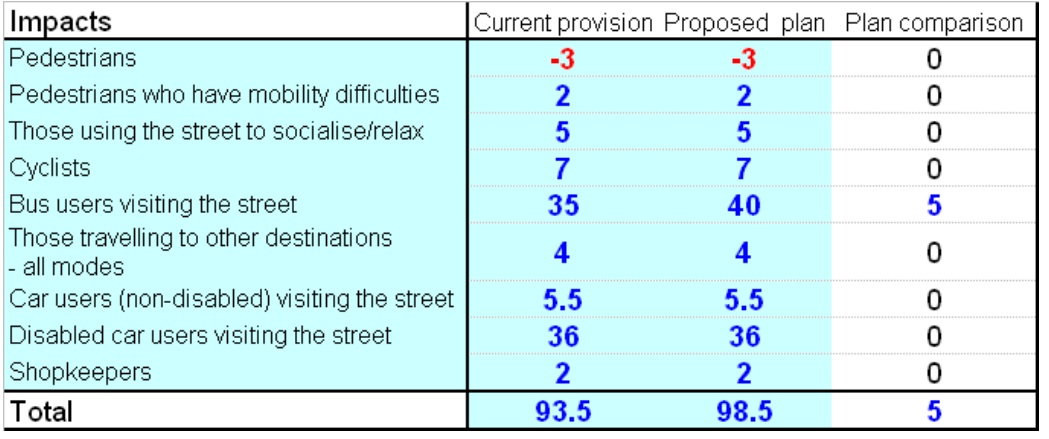
Figure 6. Assessment of the proposal by user group Source: Derived from Jones and Paskins (2008a), Table